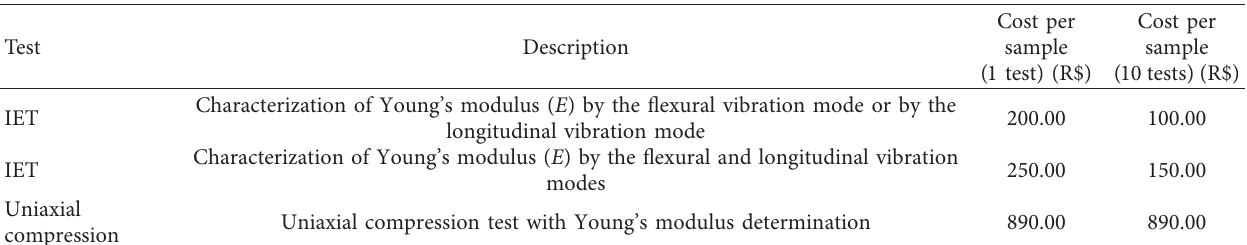
Table 5: Costs for conducting Young’s modulus assays by pulse excitation and uniaxial compression methods.